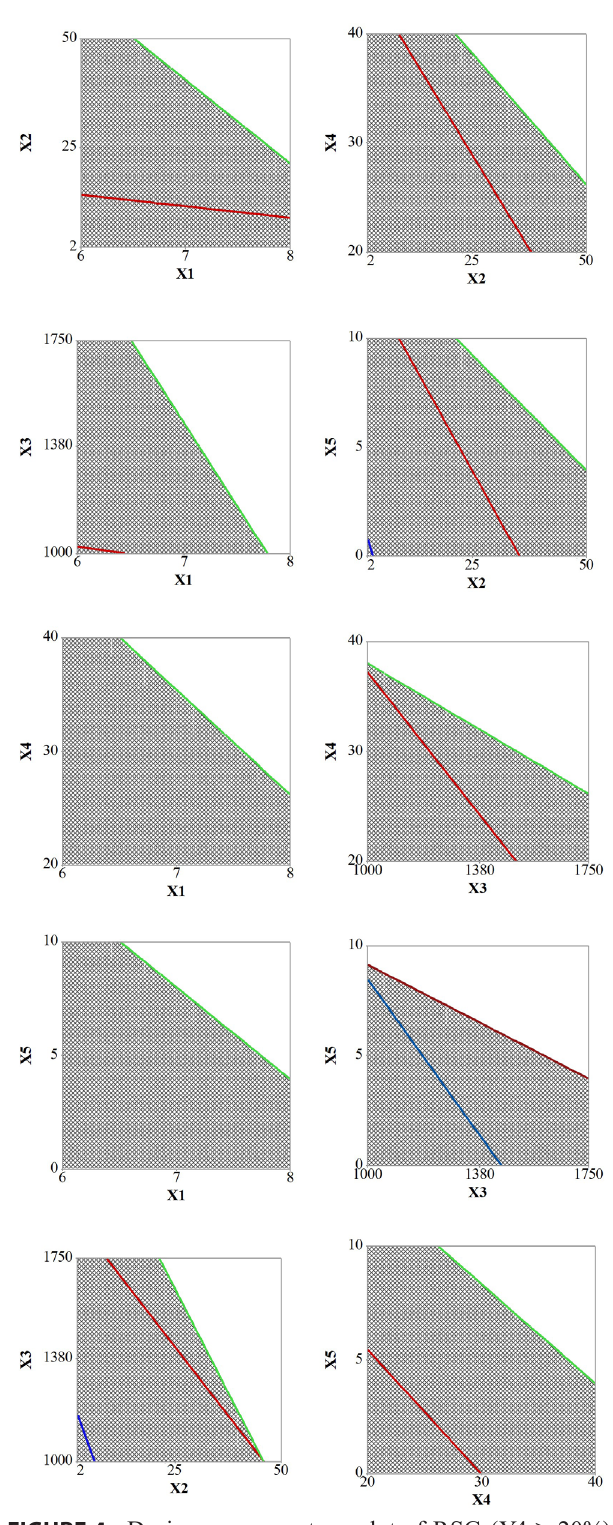
FIGURE 4 - Design space contour plot of RSG (Y4 ≥ 20%), N-Dm-R (Y5 ≥ 20%), and p-OH-R (Y6 ≥ 20%) as function of pH (X1, 6 to 8), HCl concentration (X2, 2 to 50 mmol/L), agitation speed (X3, 1000 to 1750 rpm), extraction time (X4, 20 to 40 min), and NaCl concentration (X5, 0 to